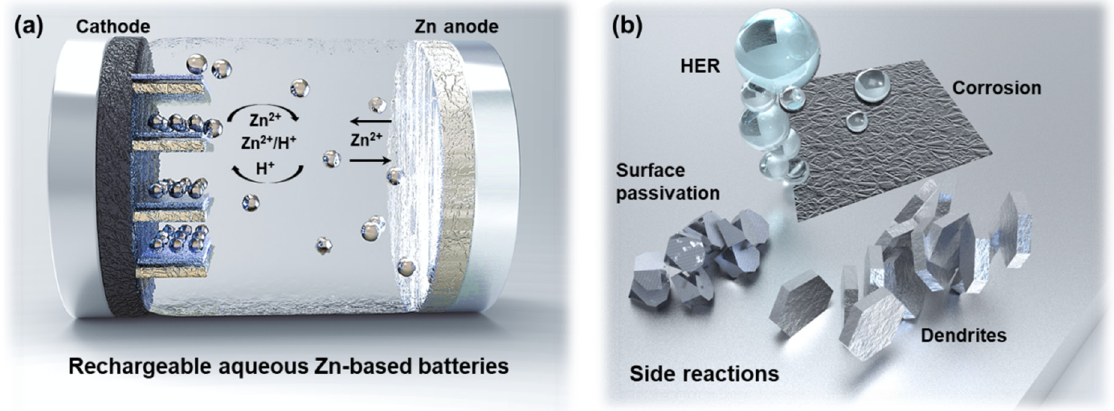
Figure 1. ( a ) Schematic illustration of working mechanism, and ( b ) side reactions of rechargeable Zn-based batteries in mild acid/neural electrolytes.